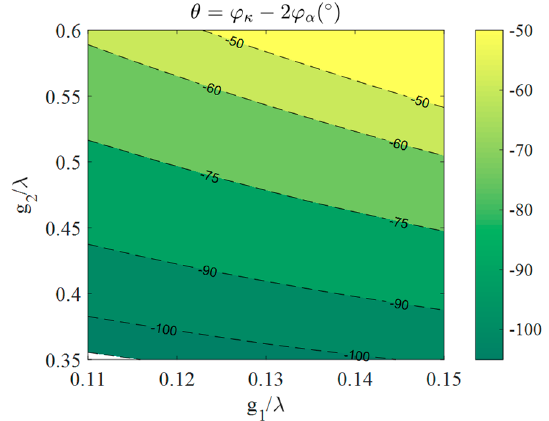
Figure A5. Contour of θ as a function of g 1 and g 2 . The normalized capacitance C λ means capacitance per electrical period and per unit length of aperture, shown in Figure A6.